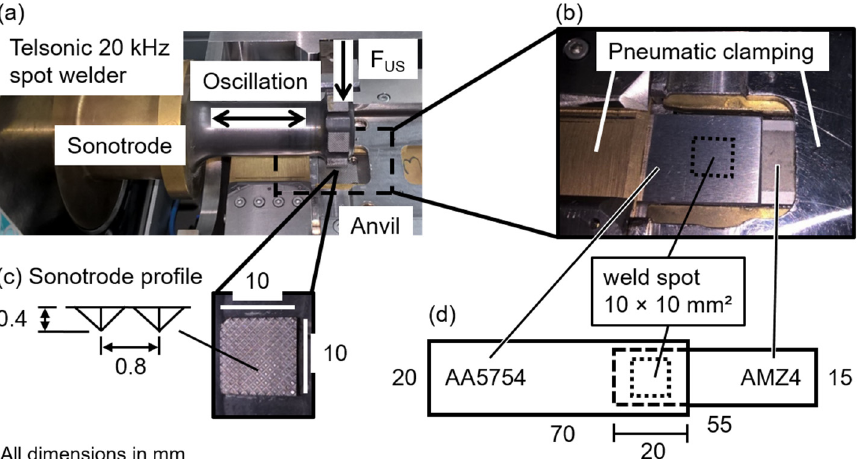
Figure 2. ( a ) The Telsonic spot welder, oscillating at 20 kHz, with custom-made anvil for positioning and clamping of AA5754 and AMZ4. ( b ) AA5754 and AMZ4 clamped separately before welding; the dotted square indicates the position of the weld spot. ( c ) Details of the square 10 × 10 mm 2 sonotrode profile with pyramids of 0.4 mm height and 0.8 mm distance from each other. ( d ) Geometry of the overlapping specimens with AA5754 on the tool side.